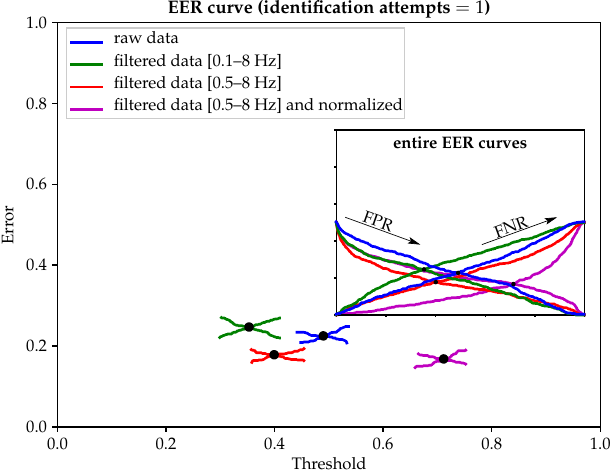
Figure 3. Minimum equal error rate (EER) for different input photoplethysmographic (PPG) signal preprocessing modalities. The inset shows the entire EER curves as well as FPR (false positive rate) and FNR (false negative rate) trends for different threshold